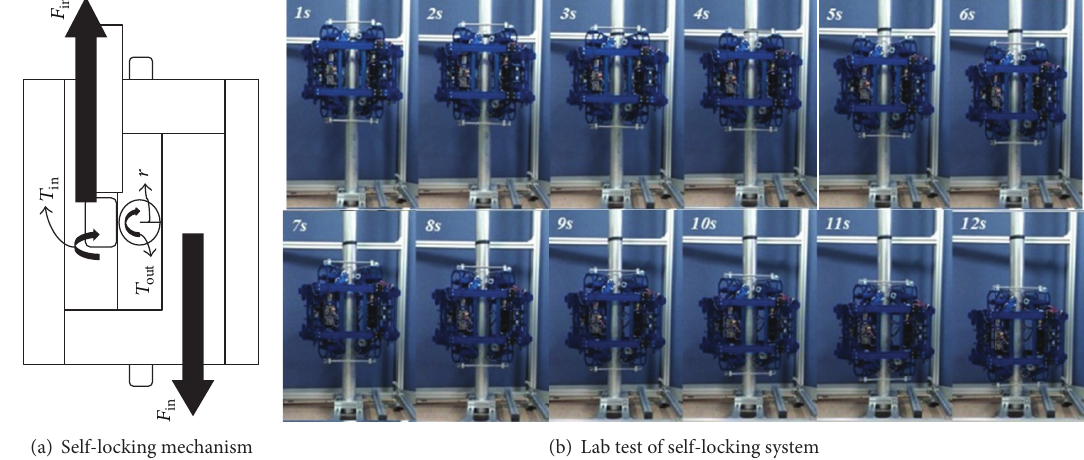
Figure 17: The climbing robot unit and self-locking mechanism for vertical hanger cables in suspension bridges [55].